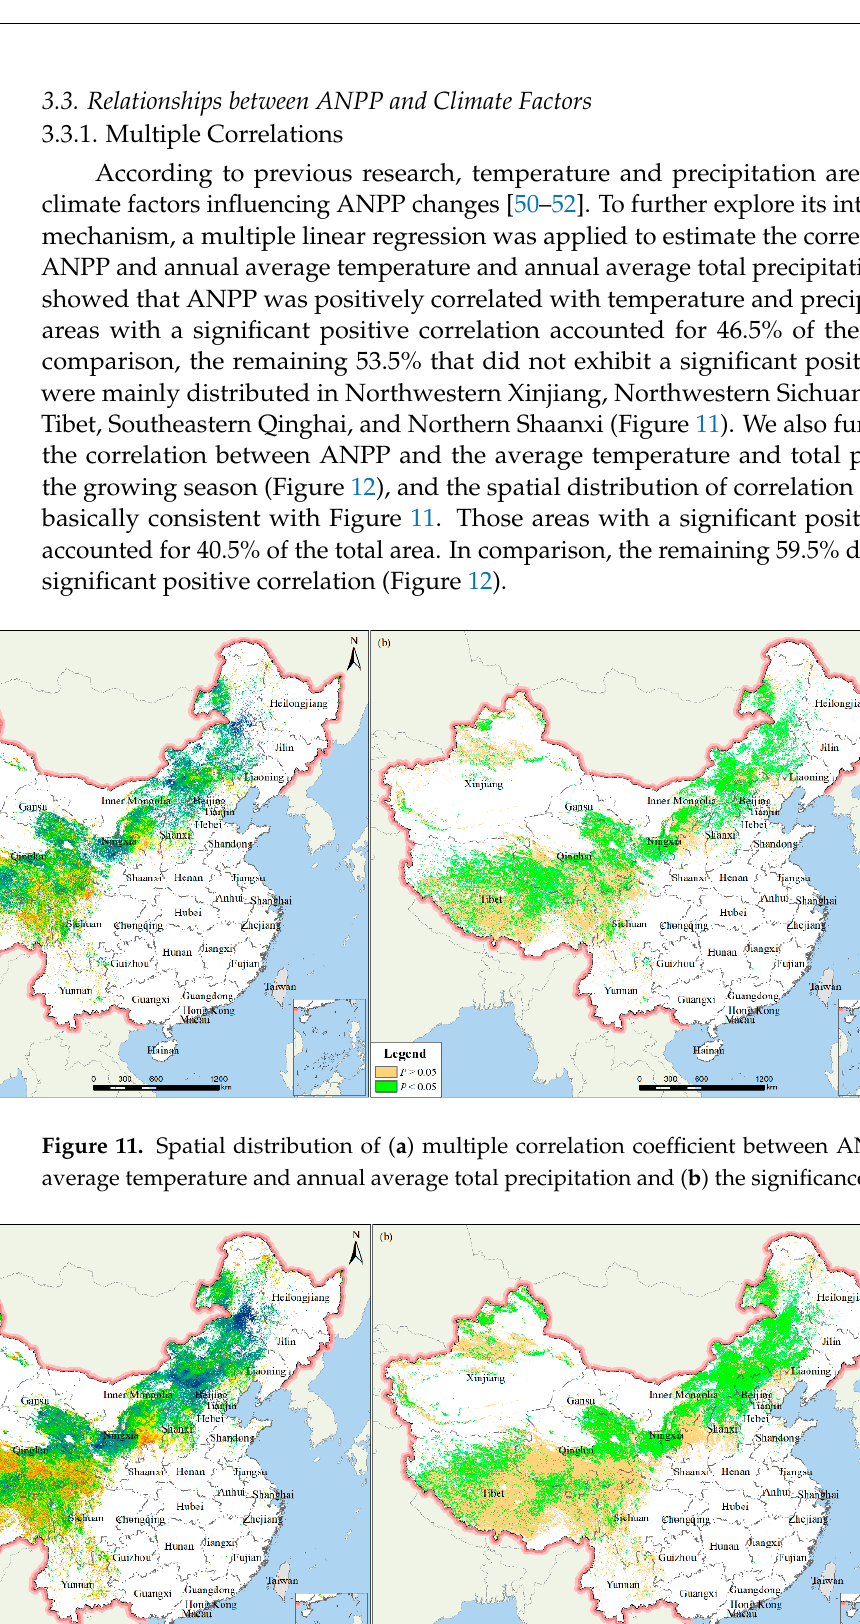
Figure 10. Spatial patterns of ( a ) driving factors and ( b ) contributions to ANPP changes.